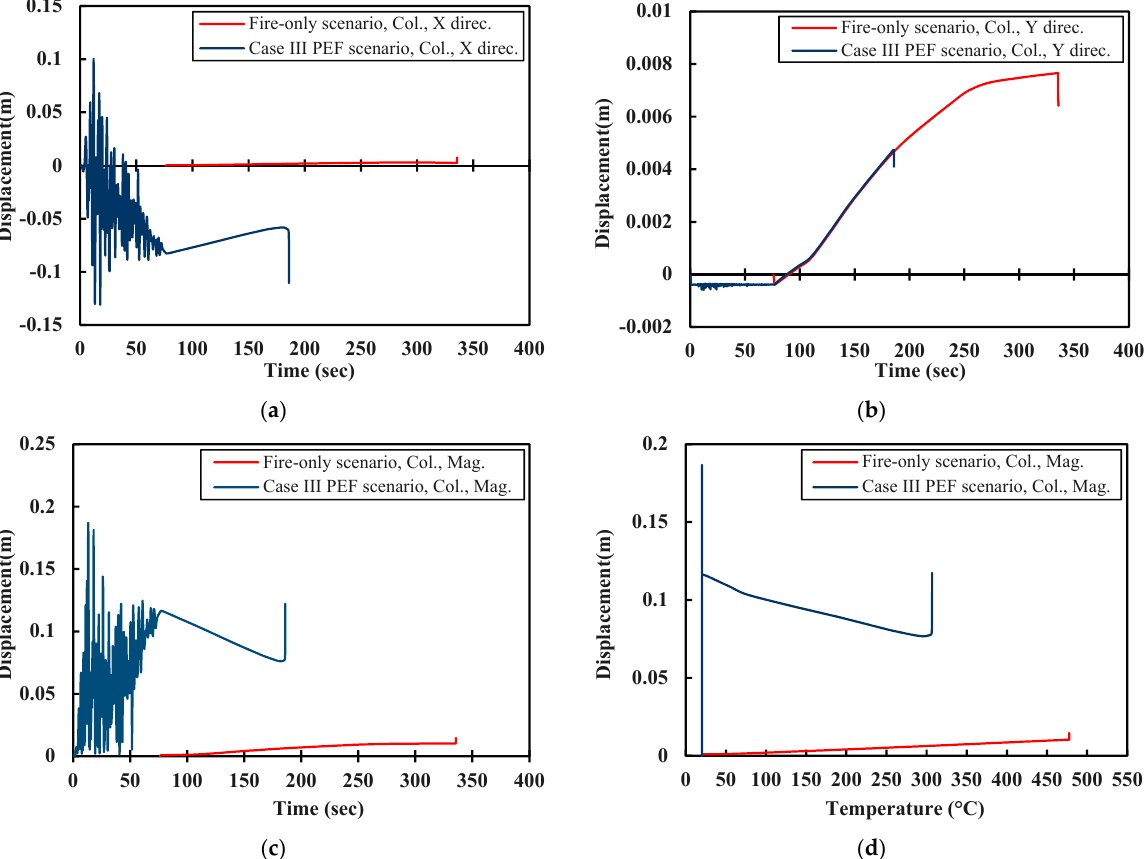
Figure 16. Comparison of the displacement values at a point which is 1.4 m along the column length for both the fire-only and PEF events for Case III including ( a ) the time-displacement record in the x-direction, ( b ) the time-displacement record in the y-direction, ( c ) the time-displacement record for total displacement value and ( d ) the temperature-displacement record for the total displacement value.